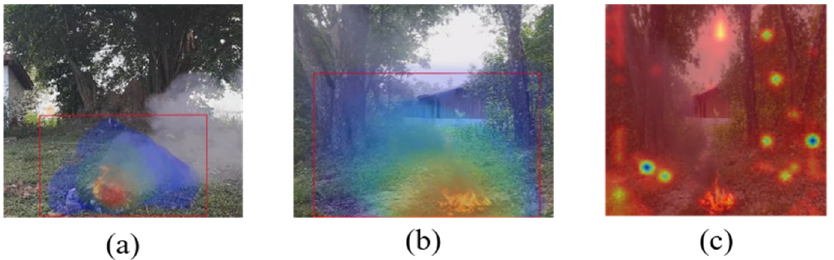
Figure 7. The results drawn from the Vision Transformer-based explainable object detection using meta-learning mining. ( a , b ) Grad-CAM normally captures the highest importance in fire prediction as fire. ( c ) incorrectly detected results.